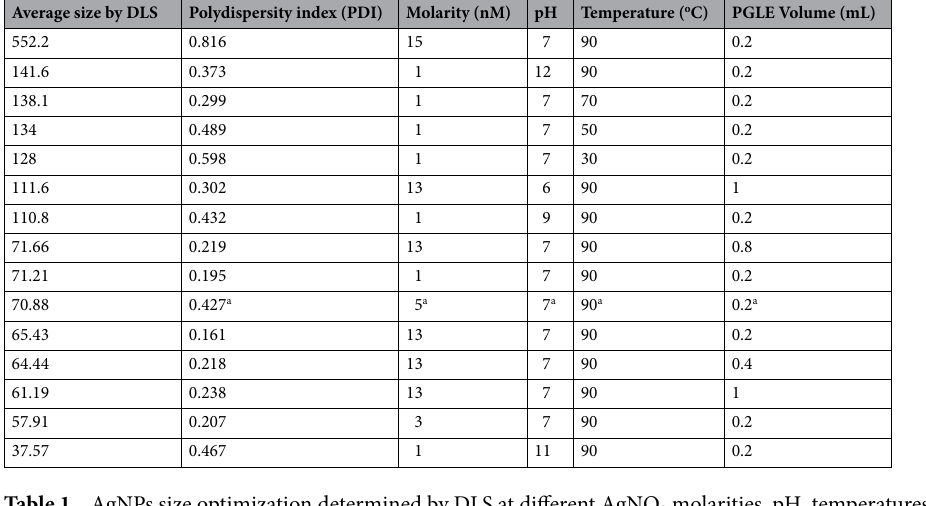
Table 1. AgNPs size optimization determined by DLS at different AgNO 3 molarities, pH, temperatures, and volumes of the added PGLE. a Chosen parameters for the synthesis of the administered AgNPs doses in rats as optimum conditions due to the production of the optimum AgNPs size, concentration, and